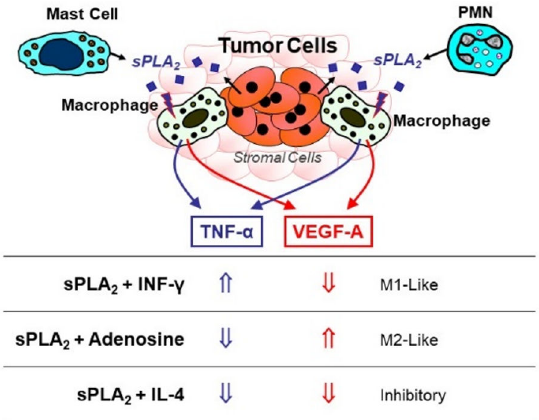
Figure 2. Hypothetical scheme depicting the complex dynamics of secreted phospholipase A2 en- zymes (sPLA 2 s) and macrophage-polarizing stimuli within the tumor microenvironment (TME). Human sPLA 2 s released in the TME by tumor cells, stromal cells or other inflammatory cells infiltrat- ing the tumor could act as a driving stimulus activating TAMs to produce cytokines, chemokines and angiogenic factors, without a clear polarization toward an M1- or M2-like functional output. In the presence of additional polarizing stimuli, such as interferon γ (IFN γ ), interleukin (IL)-4 or adenosine, the phenotype of sPLA 2 -activated TAMs can be further fine-tuned, thereby modulating the functional